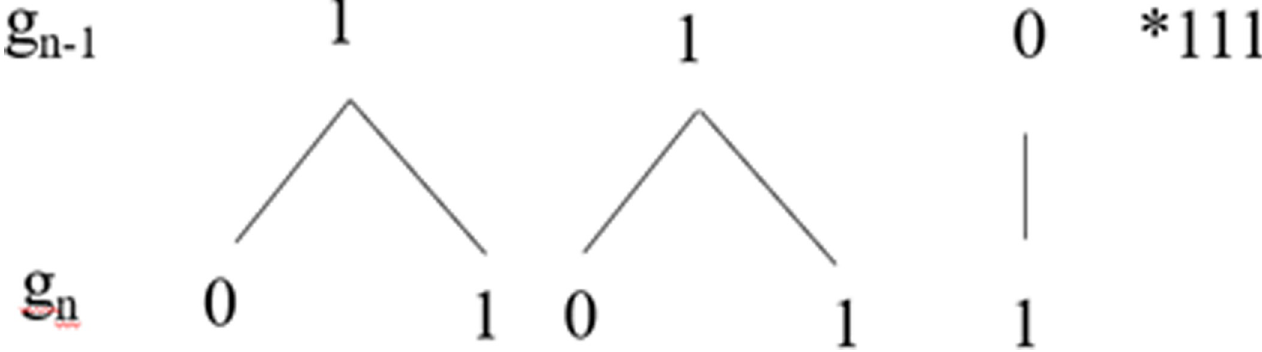
Fig 3. Disambiguation of the sequence [0101].